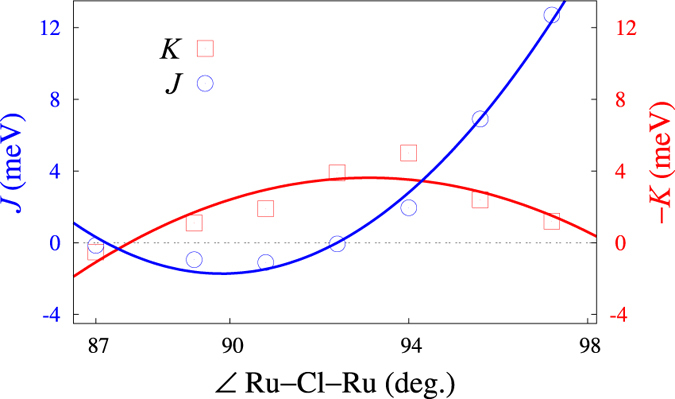
Variation of the NN Heisenberg and Kitaev couplings with the Ru-Cl-Ru angle in model C2/m-type structures.Results of spin-orbit MRCI calculations. The NN Ru-Ru distance is set to 3.44 Å and the Ru-Cl bond lengths are for each angle all the same. The variation of the Ru-Cl-Ru angle is the result of gradual trigonal compression. Curves are drawn just as a guide for the eye.